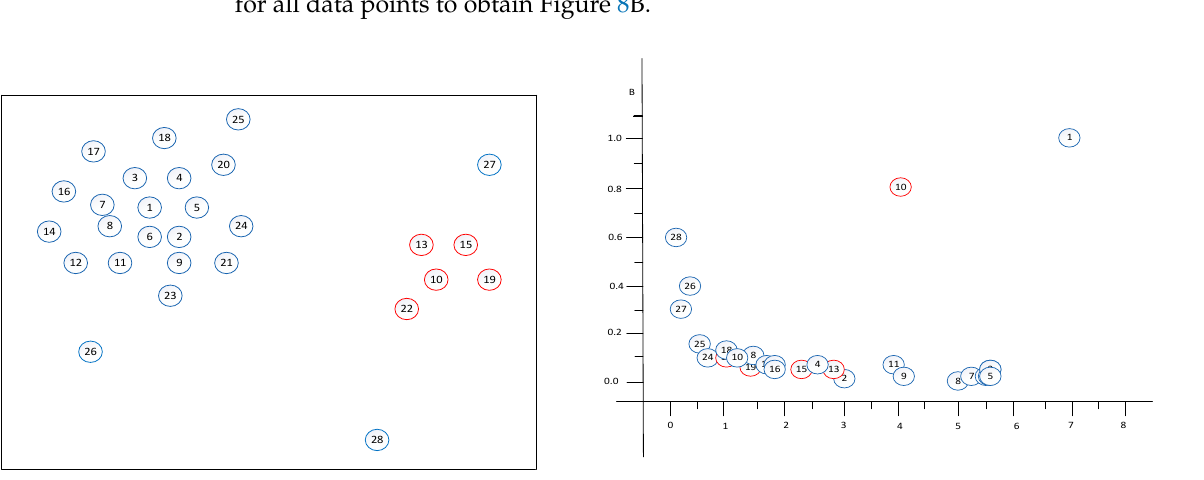
Figure 8. Dataset to be classified. ( A ) Dataset cluster class. ( B ) The figure of similarity distance.